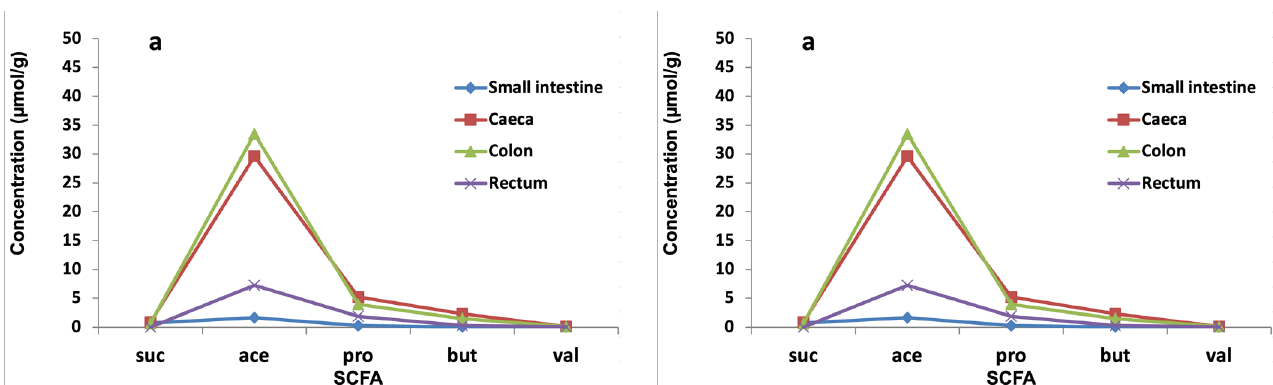
FIGURE 3 - SCFA content in intestinal segments in NWS group (a) and AWS group (b)